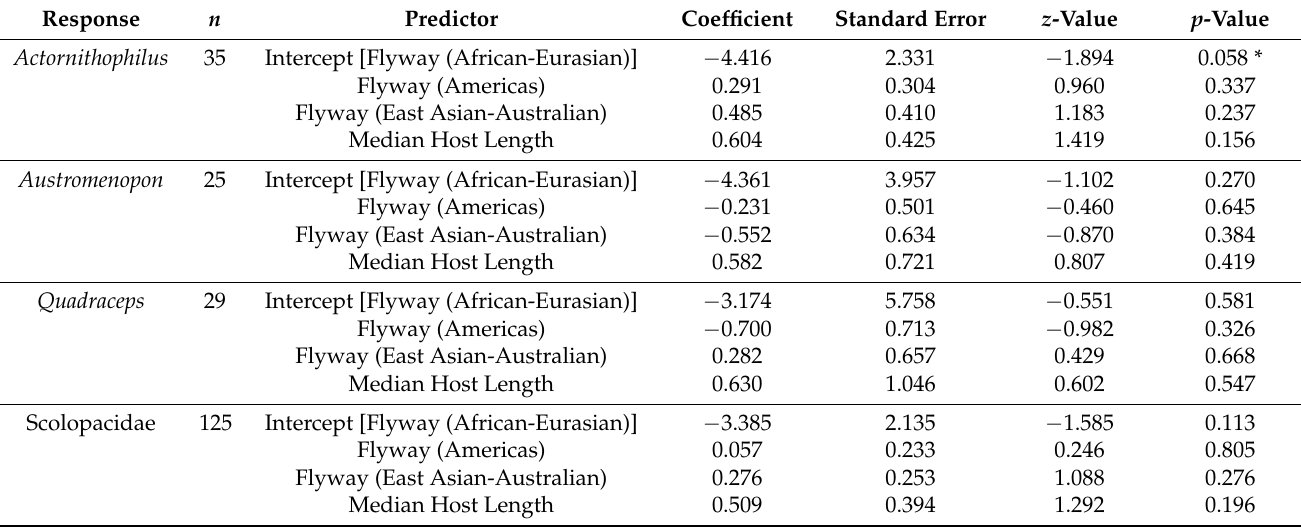
Table 6. Summary of GLMM (beta distribution and logit-link function) of the effects of flyway and host length on the prevalence of lice. An asterisk (*) designates the only statistically significant value.